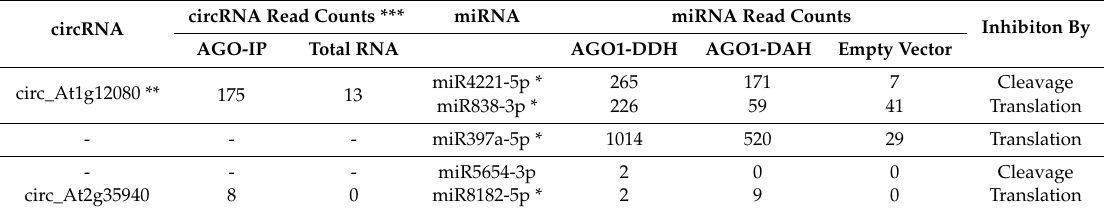
Table 3. Read counts of circRNA and microRNAs that are potentially